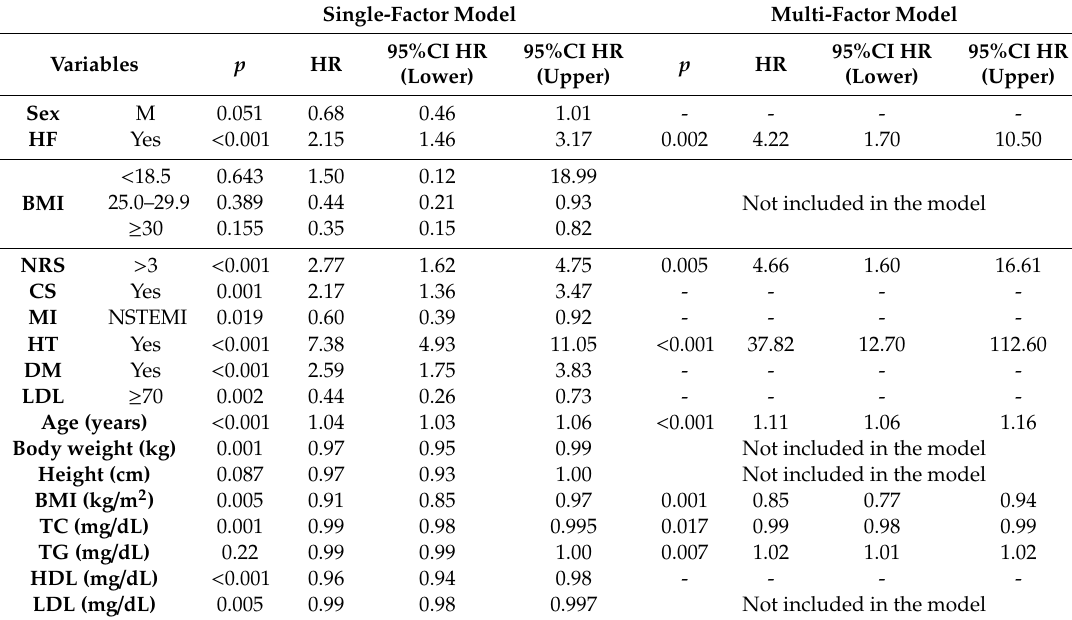
Figure 4. Comparison of survival curves depending on LDL result. Abbreviations: LDL, low-density lipoprotein. Table 5. Evaluation of the influence of variables on mortality—regression proportional hazards model, single- and multi-factor